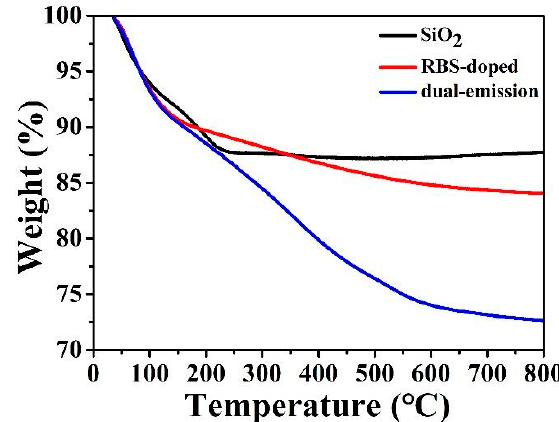
Figure 4. Thermogravimetric analysis (TGA) result of SiO 2 microspheres, RBS-doped silica microspheres, and dual-emission fluorescent microspheres.